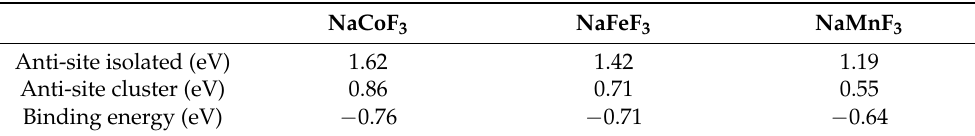
Table 2. Calculated formation energies for isolated and clustered anti-site defects in NaMF 3 (M = Co, Fe, and Mn). NaCoF 3 NaFeF 3 NaMnF 3 Anti-site isolated (eV) 1.62 1.42 1.19 Anti-site cluster (eV) 0.86 0.71 0.55 Binding energy (eV) − 0.76 − 0.71 −